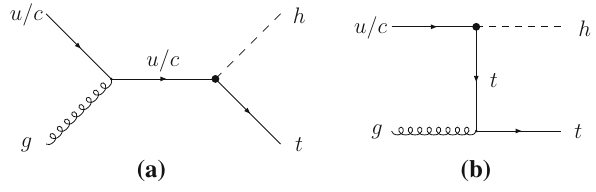
Fig. 1 The Feynman diagrams for th production at the LHC through FCNC tqh interactions